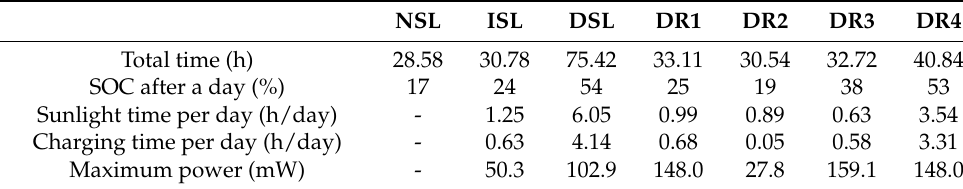
Figure 16. Battery current vs. time of DR4 and NSL experiments. Table 2. Time results for all